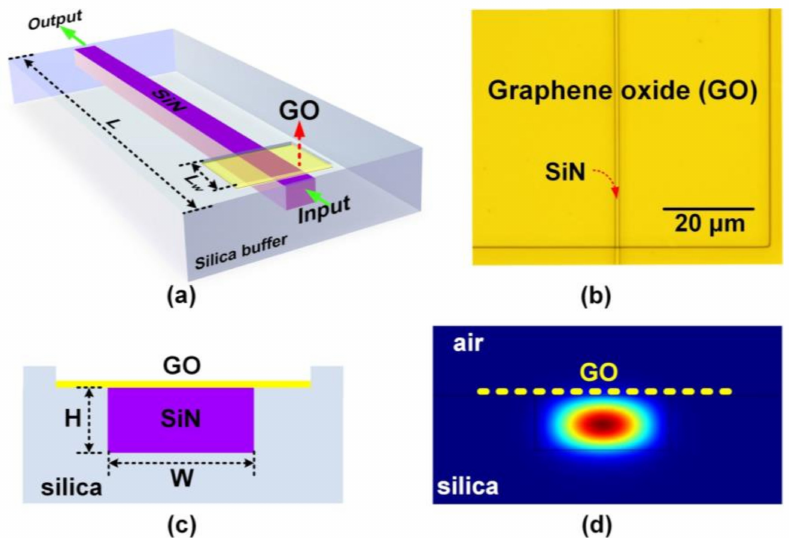
Figure 1. ( a ) Schematic illustration of a SiN waveguide coated with 1 layer of GO. ( b ) A micro- graph showing the area around the opened window of the fabricated device corresponding to ( a ). ( c ) Schematic illustration of the cross-section of the hybrid waveguide. ( d ) TE mode profile corre- sponding to ( c